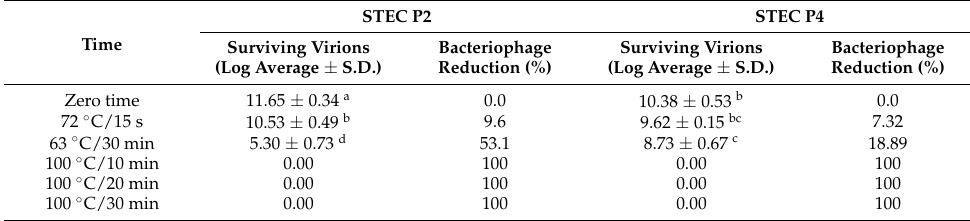
Table 4. Thermal stability of STEC P2 and STEC P4.